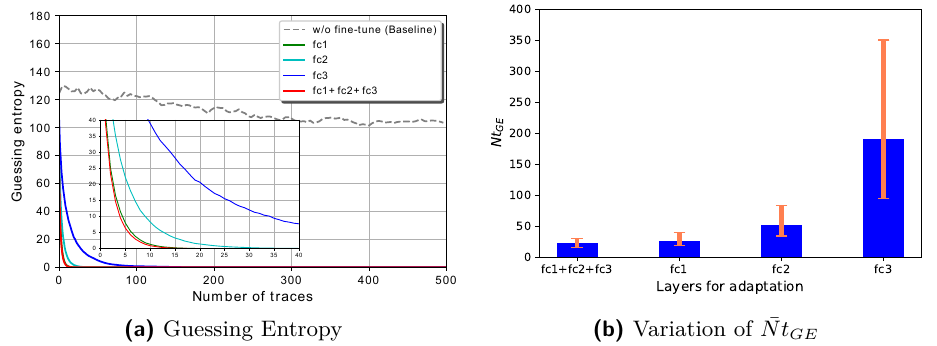
Figure 14: Attacking results of different adaptation layers (average over 20 fine-tuned